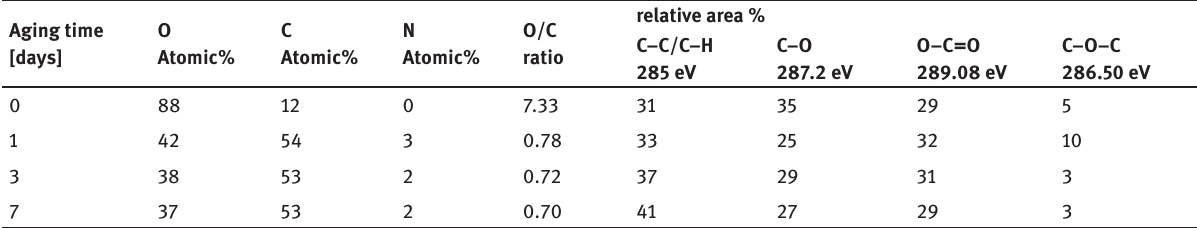
Table 3 : Aging of PLA sample treated 10 s at 350 W.